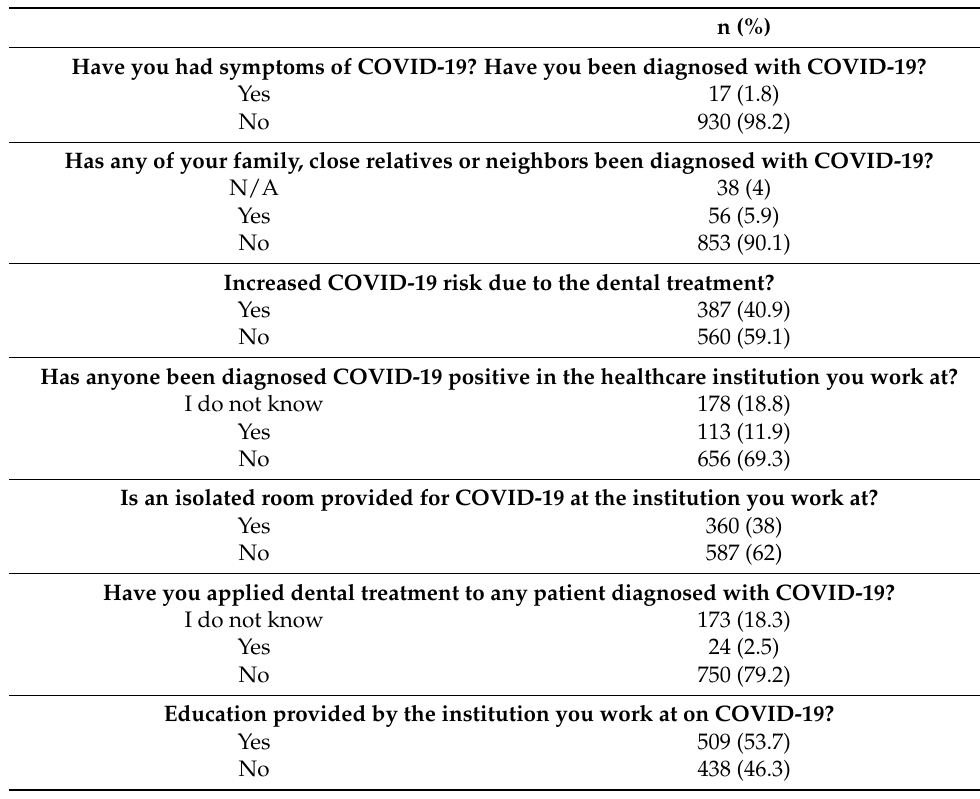
Table 3. COVID-19 positivity, facilities and educational status.